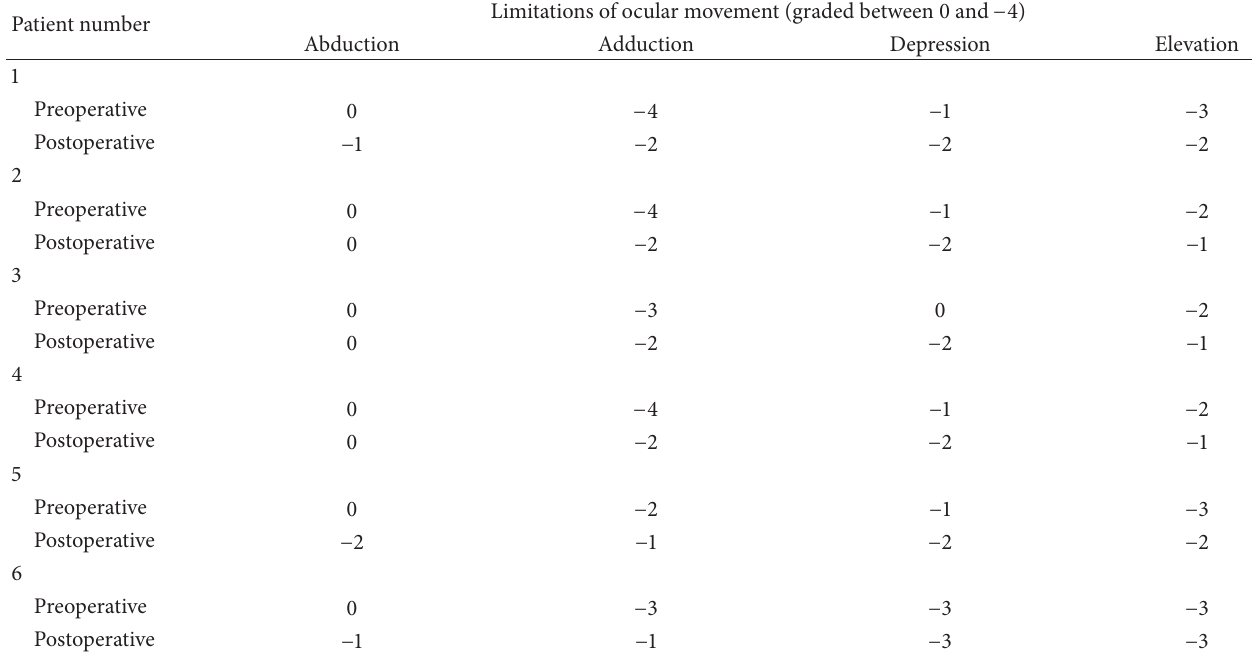
Table 3: Limitations of ocular movement at involved eyes.